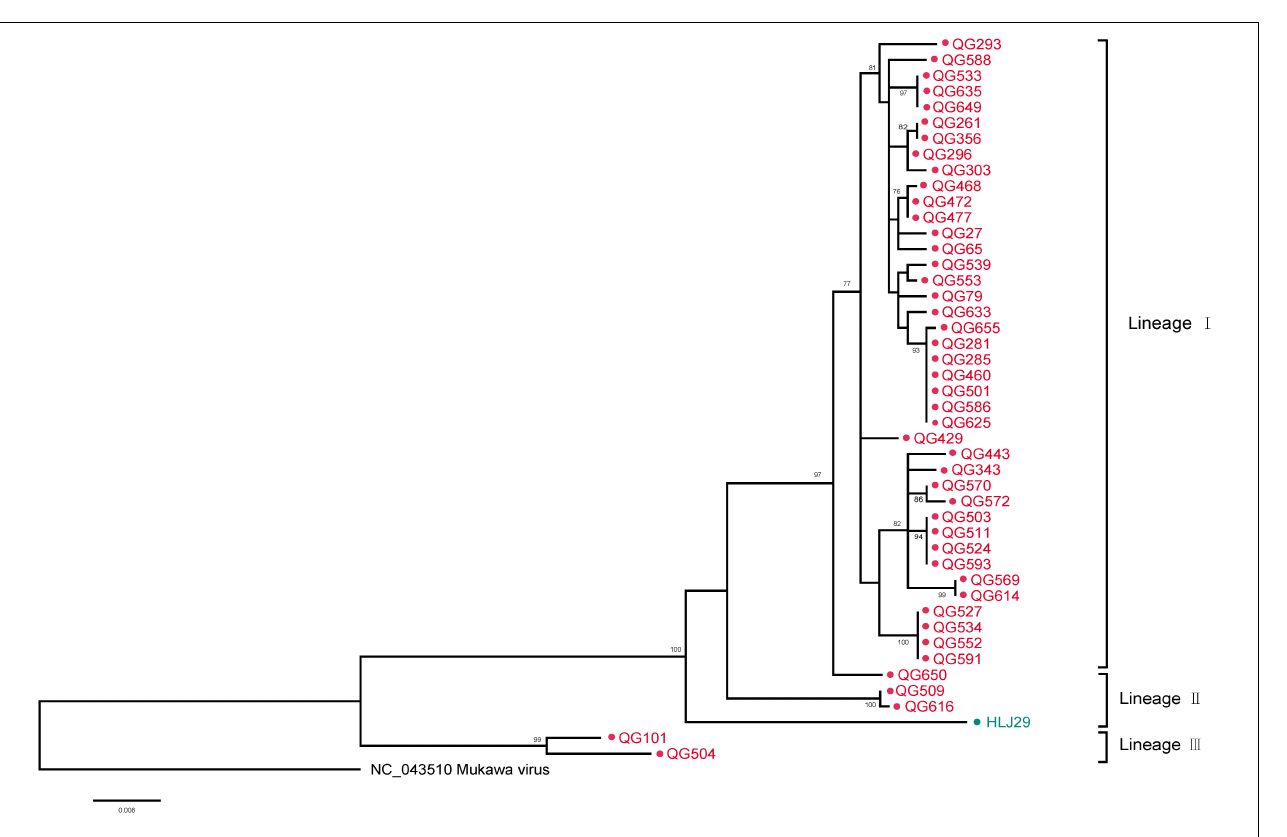
Frontiers in Microbiology |